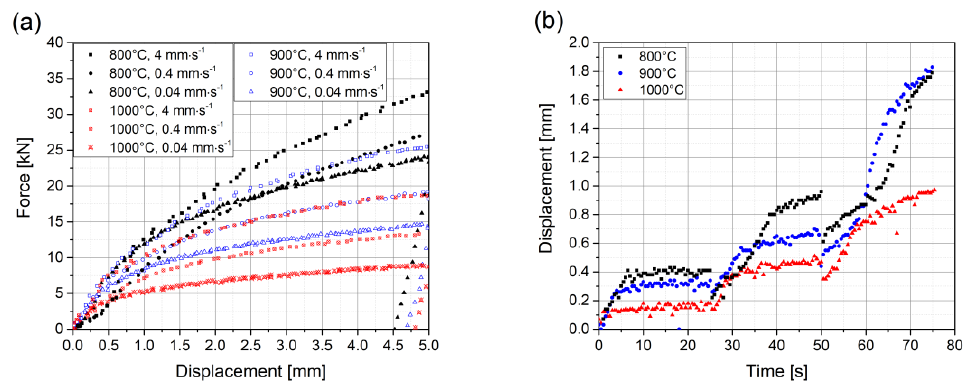
Figure 5. ( a ) Experimental results of displacement-controlled tests. All three strain rates for the three representative temperatures—800, 900, and 1000 ◦ C—are displayed. For the experiments with the lowest punch velocity, the unloading state is also recorded. ( b ) Experimental results of force-controlled tests for the same three temperature states. Note the di ff erent force plateaus applied and the well comparable response for the di ff erent temperatures.